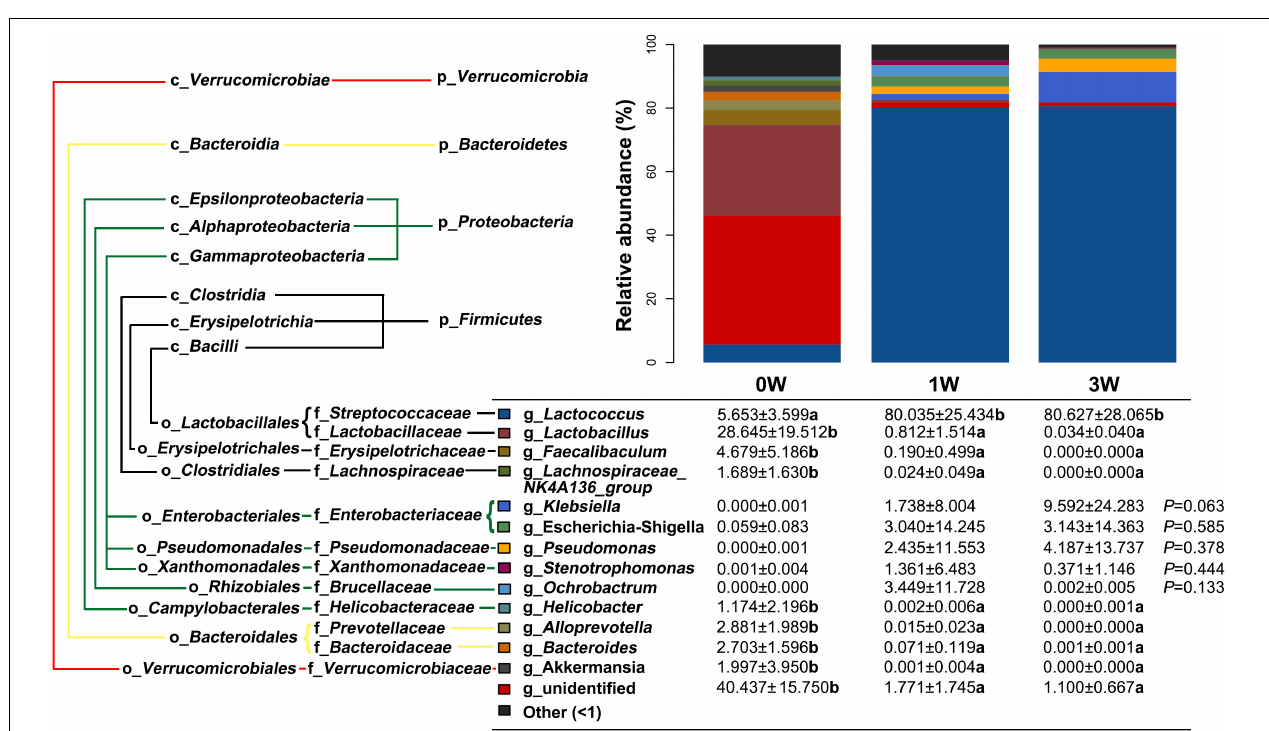
FIGURE 4 | The relative abundance of fecal microbiota at the genus level. Data represented as mean ± SD ( n = 24). Bars with different letters differ significantly ( P < 0.05). g_ represents microbial genus.